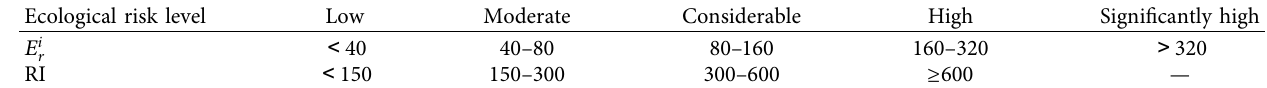
Table 2: Classification of potential ecological risk